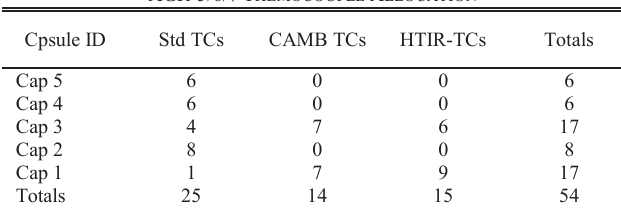
Fig. 1. Elevation view of typical AGR fuel experiment.